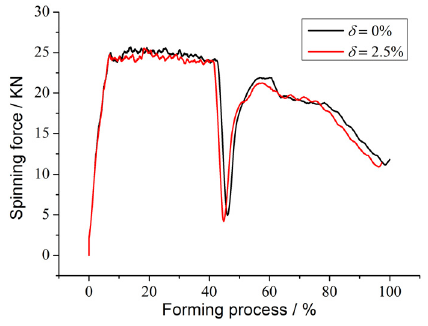
Figure 11. The change of the spinning force when δ changes.